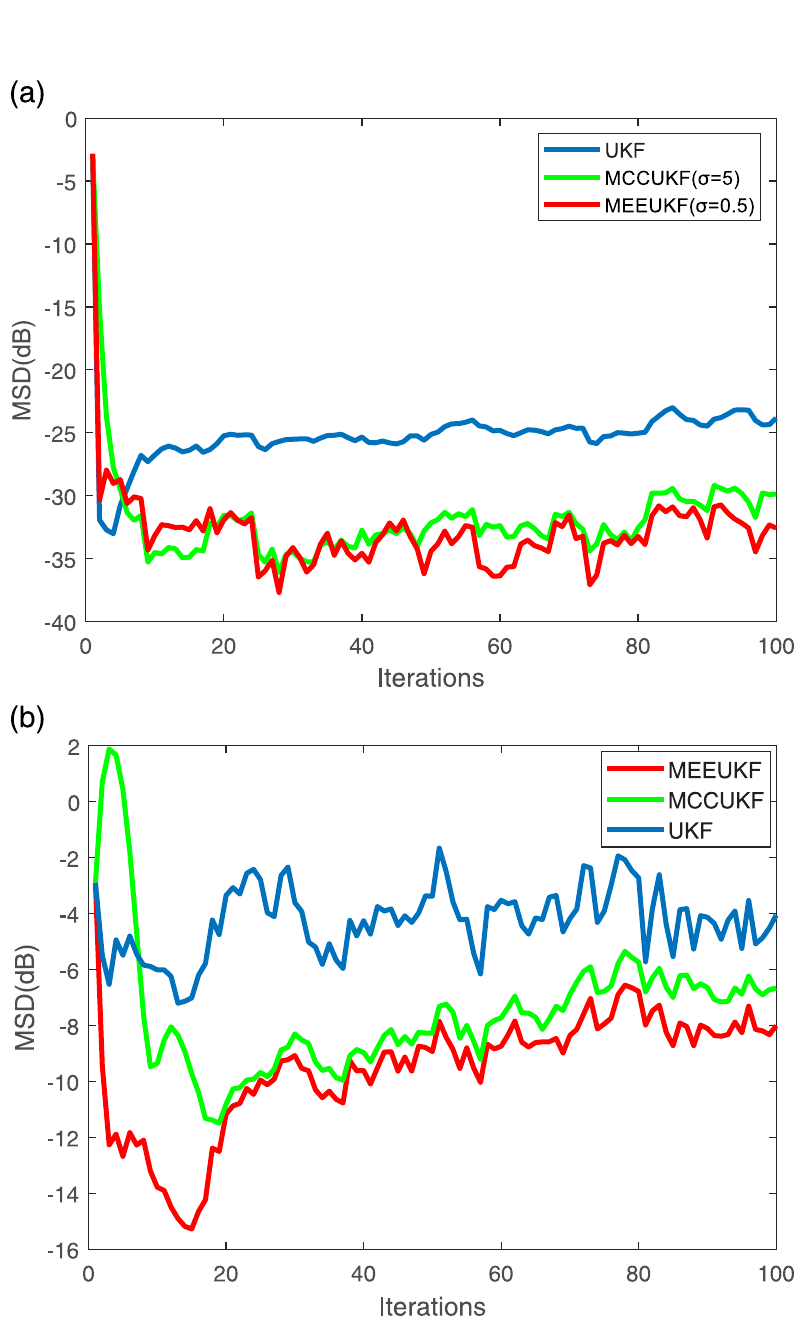
Fig 2. Convergence curves under different noises. The figure depicts the performance of the algorithm compared with UKF and MCCUKF in the presence of Mixed Gaussian and Rayleigh noises. (a) Mixed Gaussian noise. (b) Rayleigh